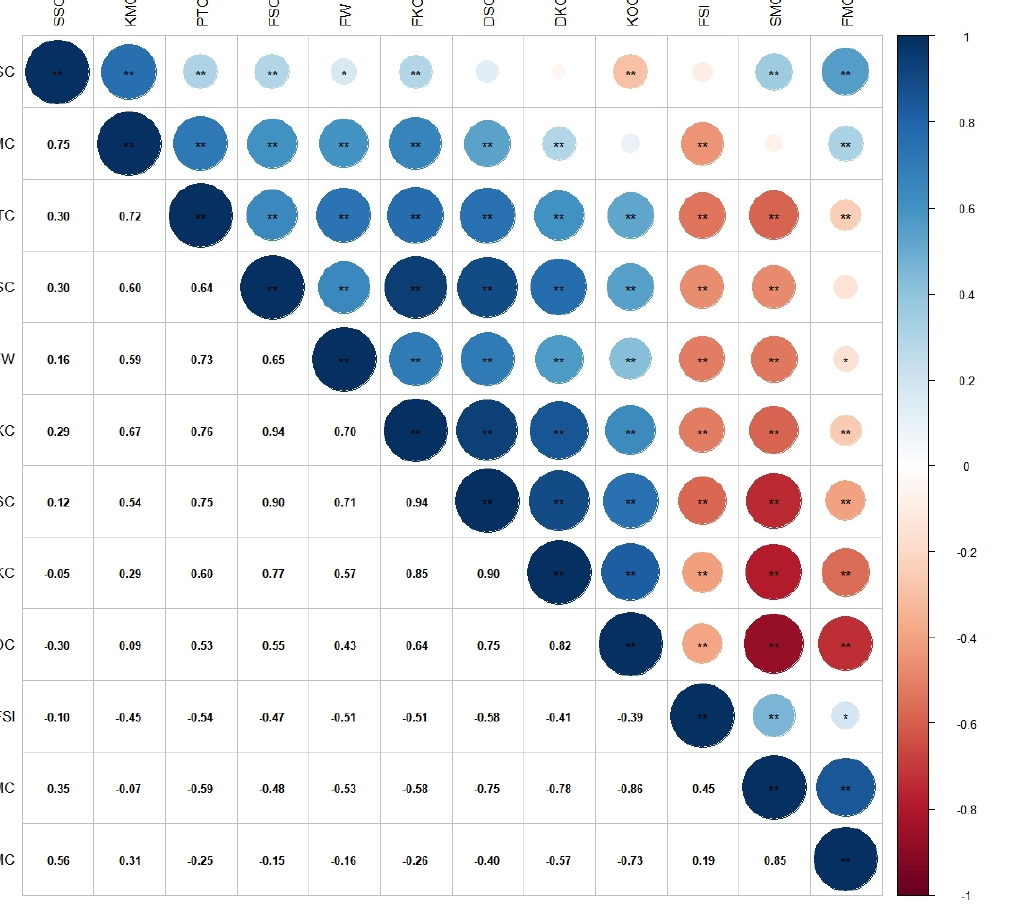
Figure 9. The correlation heatmap between fruit qualities during the whole growing period in C. oleifera ‘Huaxin’. * < 0.05, ** ≤